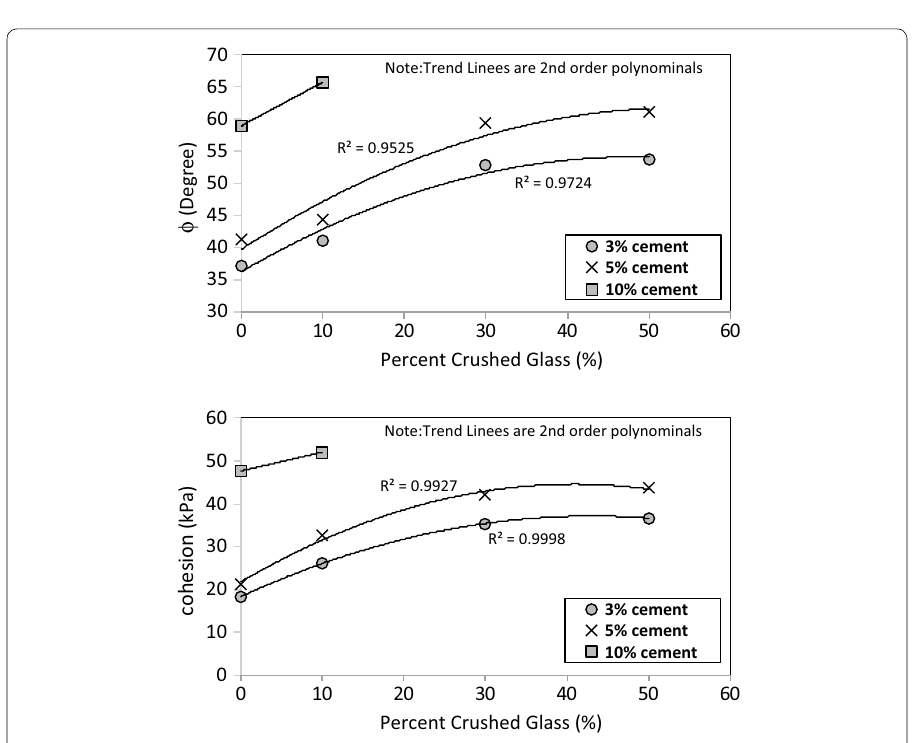
Fig. 4 Strength parameters (φ, c) for stabilized SM and CG–SM